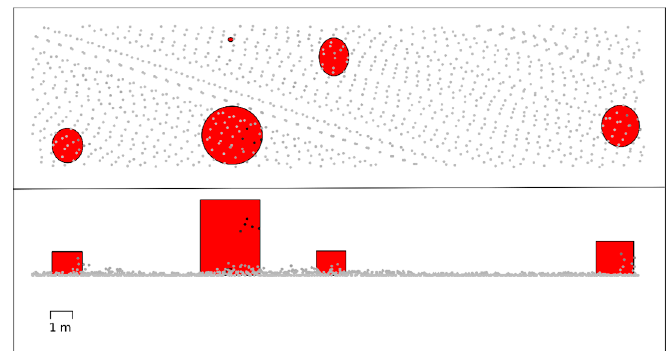
Figure 2. Visualization of five field-measured trees, and the ALS echoes from ALS2012 in the corresponding area. Viewed from above ( upper figure ) and from the side ( lower figure ). The field-measured height and crown extent is colored red, and the ALS echoes are colored from grey to black. The highest echoes are colored black. Note that the terrain height has been subtracted from the ALS echo heights (see text for details), and that only a sample of trees was measured.